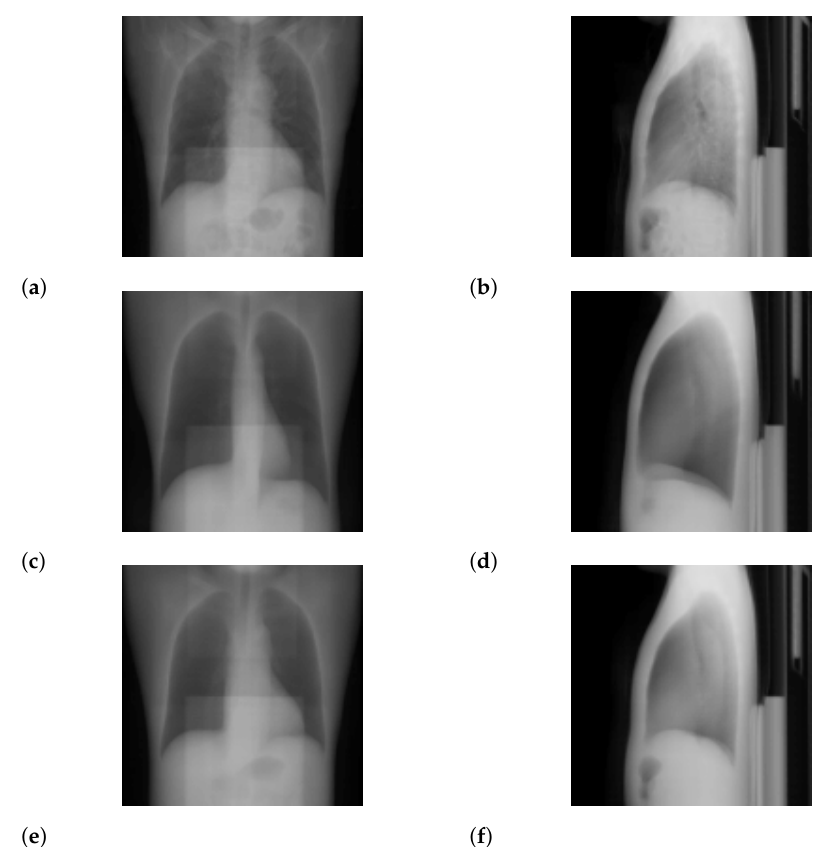
Figure 3. Input images and projections of a reconstructed image ( N = 2): ( a , b ) input images, ( c , d ) projections of an initial guess image (sampled with temperature T = 0.5), ( e , f ) projections of the optimum reconstructed image. The intensities of these images were modified to enhance